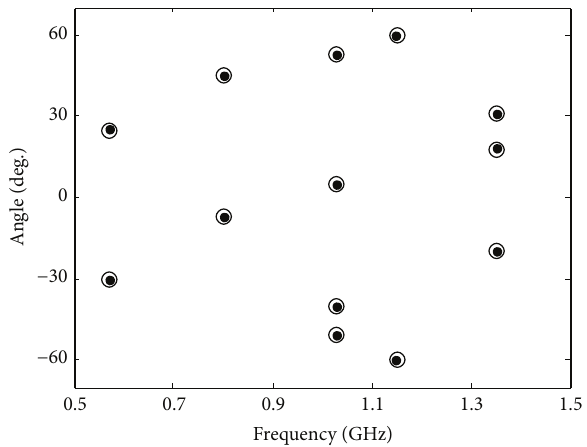
Figure 4: Pair mathcing results of 13 source signals, SNR = 15